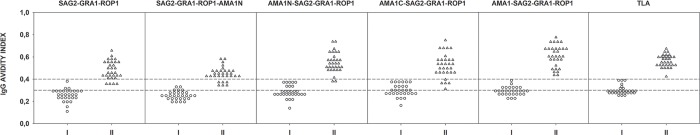
Avidity indexes obtained for sera from patients with suspected acute (I–IgM +, IgG +, low avidity) and chronic phase of T. gondii infection (II–IgM–, IgG +, high avidity) with SAG2-GRA1-ROP1, SAG2-GRA1-ROP1-AMA1N, AMA1N-SAG2-GRA1-ROP1, AMA1C-SAG2-GRA1-ROP1, AMA1-SAG2-GRA1-ROP1 chimeric proteins and TLA.The horizontal lines represent the borderline values of avidity indexes (0.3 and 0.4).